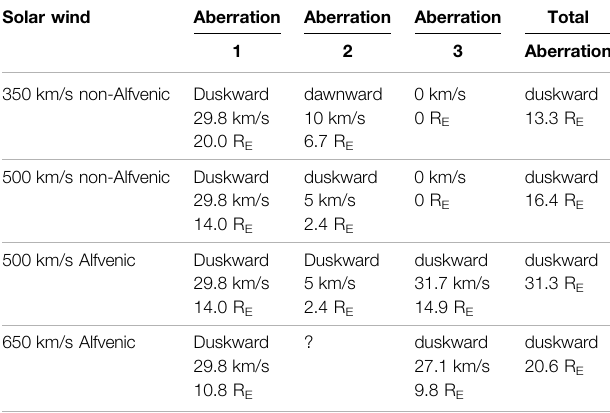
TABLE 1 | Estimates of the dusk-dawn aberrations of the proton plasma and the magnetic structure for typical solar wind